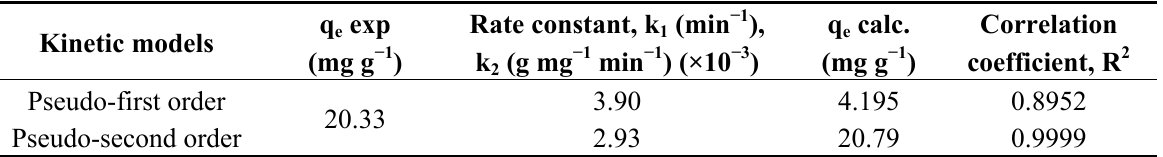
Table 4. Comparison of pseudo–first-order and pseudo–second-order rate constants k and calculated (q ea ) and experimental (q eb ) adsorption capacity